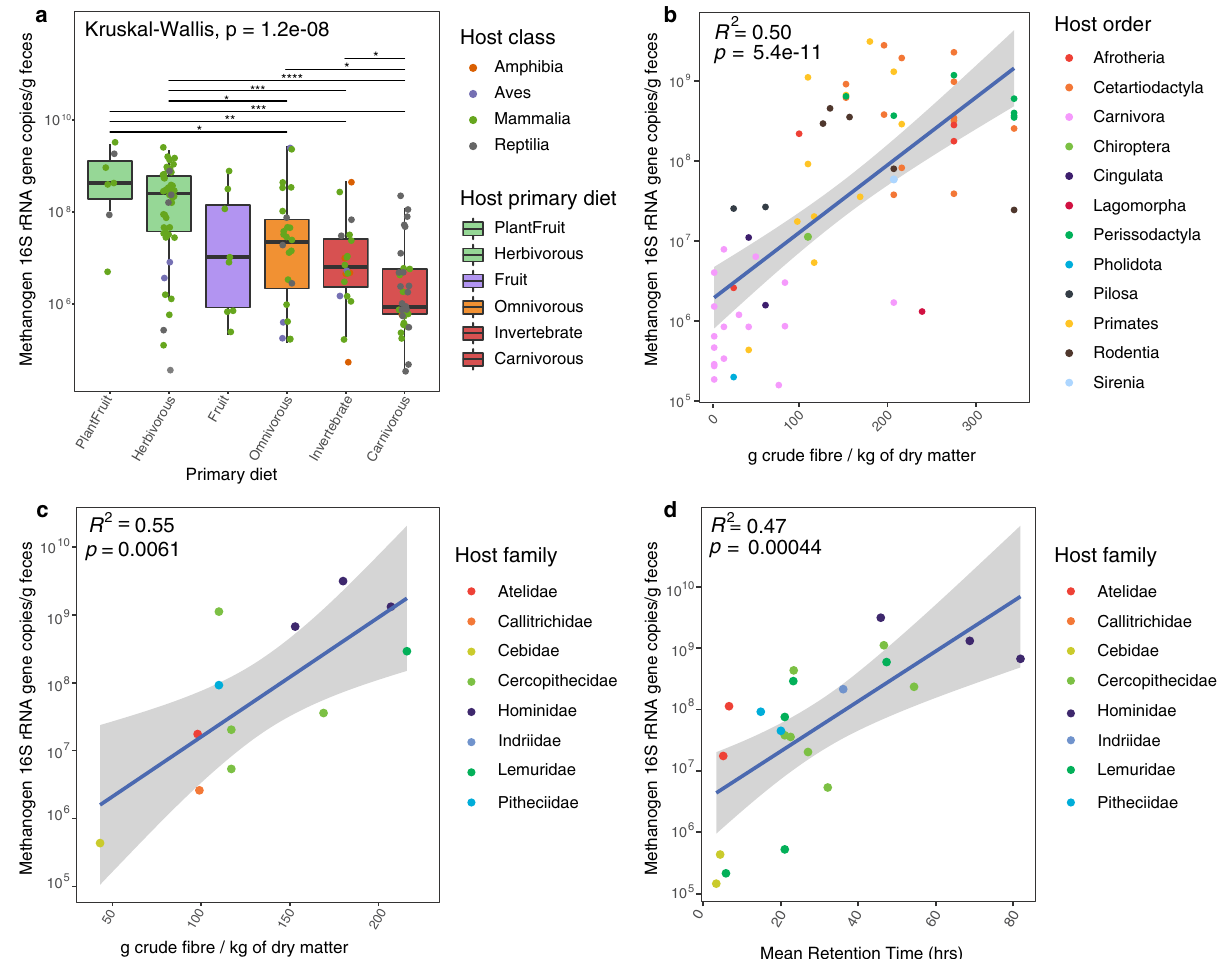
Fig. 6 In fl uence of host diet type, diet- fi bre content, and mean retention time on the absolute abundance of total methanogens. a Abundance of total methanogens ( n = 139) in animals grouped by diet type. The abundance of methanogens is the sum of individual quanti fi cations of Methanobacteriales , Methanomicrobiales , Methanomassiliicoccales and Methanimicrococcus 16S rRNA genes. Two-sided Wilcoxon rank sum test with continuity correction was used to determine differences between diet types, * p ≤ 0.05; ** p ≤ 0.01; *** p ≤ 0.001; **** p < 0.0001. Signi fi cant differences across all groups were determined via the Kruskal-Wallis test, with p < 0.05 set as signi fi cant. Correlation between diet- fi bre content and ( b ) absolute abundance of methanogens in mammal species ( n = 65) and ( c ) in primates ( n = 12). d Correlation between digesta mean retention time and averaged absolute abundance